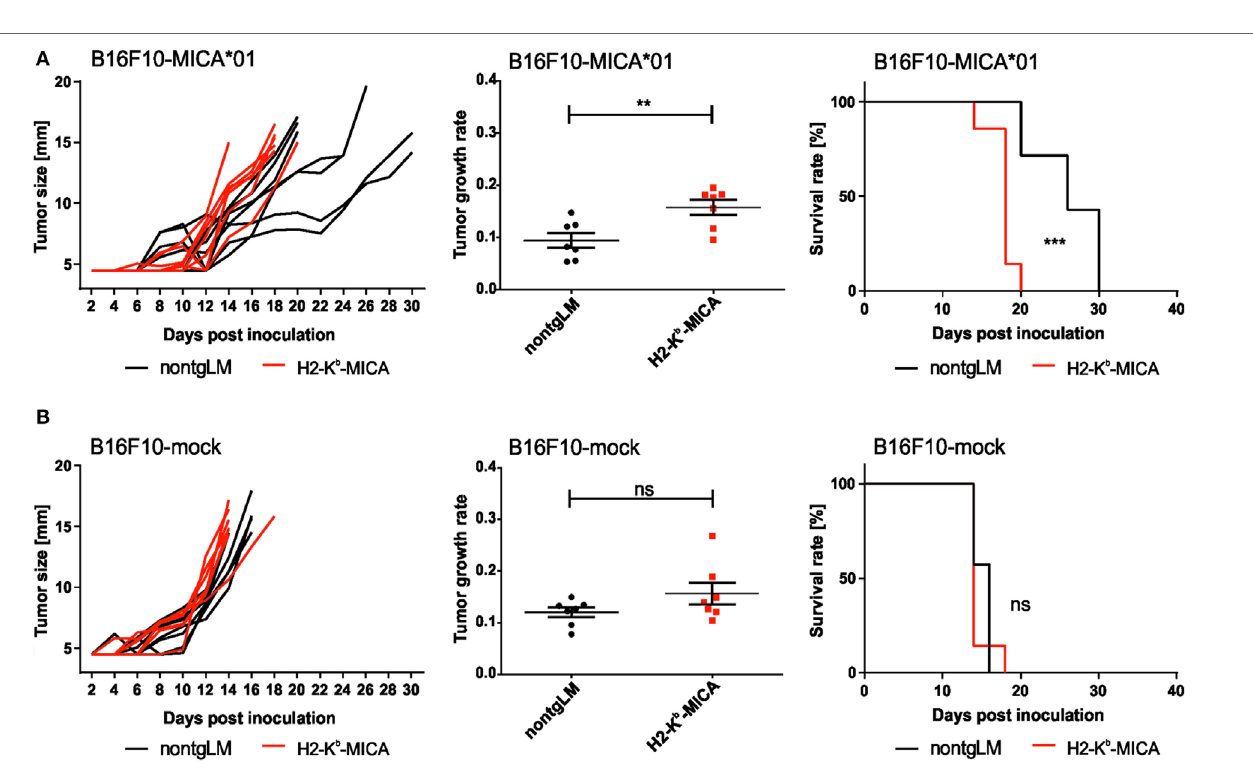
FigUre 4 | Chronic engagement of NKG2D in vivo does not affect tumor growth of B16F10 melanoma. (a,B) H2-K b -MICA mice (red lines/dots) and non-transgenic littermates (non-tgLM) (black lines/dots) were inoculated subcutaneously with (a) 1 × 10 4 B16F10-MICA*01 or (B) 1 × 10 4 B16F10-mock cells. Tumor size was measured every second day using a metric caliper and mice with a tumor size exceeding 14 mm were euthanized. Tumor growth (left panels), tumor growth rate (middle), and survival (right) is shown for seven mice per group. Growth rates of tumors were calculated as described in “Materials and Methods” section. Statistical significance of differences in tumor growth rate or in survival was calculated using unpaired t -test or log-rank (Mantel–Cox) test,